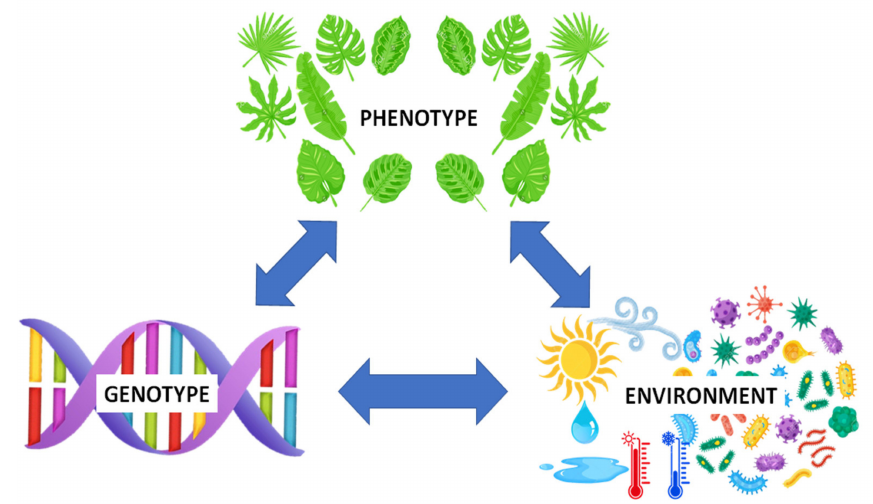
Figure 1. Abridged illustration of the genotype-environment-phenotype (G × E × P) interaction, demonstrating the interrelationship among the various components. Growth and development of plants and phenotypic plasticity are greatly influenced by the genetic composition, environmental factors and genetic x environment interactions [2,3]. The metabolome represents the final recipient of biological information flow and determines the